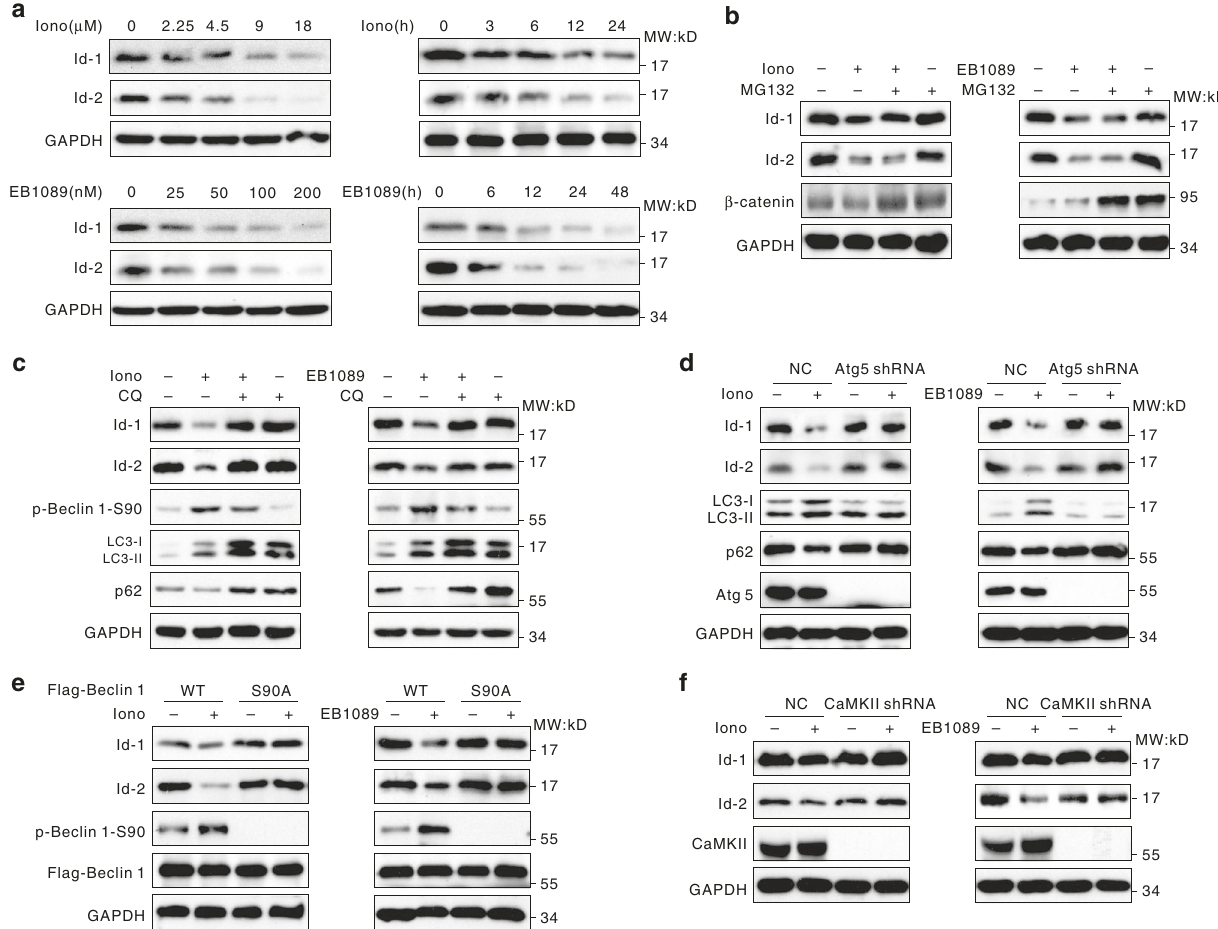
Fig. 4 Autophagy induced by CaMKII promotes degradation of inhibitor of differentiation proteins. a The degradation of Id-1 and Id-2 after ionomycin and EB1089 treatment. SK-N-SH cells were treated with 6 μ M ionomycin or 100 nM EB1089 for the indicated periods or various concentrations of ionomycin or EB1089 for 24 h. The whole-cell lysates were analyzed by immunoblotting. b The ionomycin- and EB1089-induced degradation of Id-1 and Id-2 does not occur via the proteasome pathway. SK-N-SH cells were untreated or treated with 6 μ M ionomycin or 100 nM EB1089 for 24 h and then incubated for 4 h in the presence or absence of 10 μ M MG132. The total cell extracts were subjected to western blot using the indicated antibodies. c Autophagy is involved in the ionomycin-/EB1089-induced degradation of Id-1 and Id-2. SK-N-SH cells were untreated or treated with 6 μ M ionomycin or 100 nM EB1089 for 24 h, then incubated for 2 h in the presence or absence of 10 μ M chloroquine (CQ). The whole-cell extracts were subjected to western blotting using the indicated antibodies. d Id-1/2 proteins are degraded via the autophagy pathway. SK-N-SH cells were transfected for 24 h with a negative control (NC) or Atg5 shRNA and then incubated for 24 h with 6 μ M ionomycin or 100 nM EB1089. The cell lysates were then analyzed by western blotting. e The phosphorylation of Beclin 1 Ser90 is essential for the ionomycin-/EB1089-induced degradation of Id-1 and Id-2. HEK293T cells were transiently transfected with the indicated plasmids for 24 h and then treated with 6 μ M ionomycin or 100 nM EB1089 for 24 h. The whole-cell extracts were subjected to western blotting using the indicated antibodies. f CaMKII is required for the degradation of Id-1 and Id-2 after ionomycin and EB1089 treatment. HEK293T cells were transiently transfected with negative control or CaMKII shRNA for 24 h and then treated with 6 μ M ionomycin or 100 nM EB1089. The